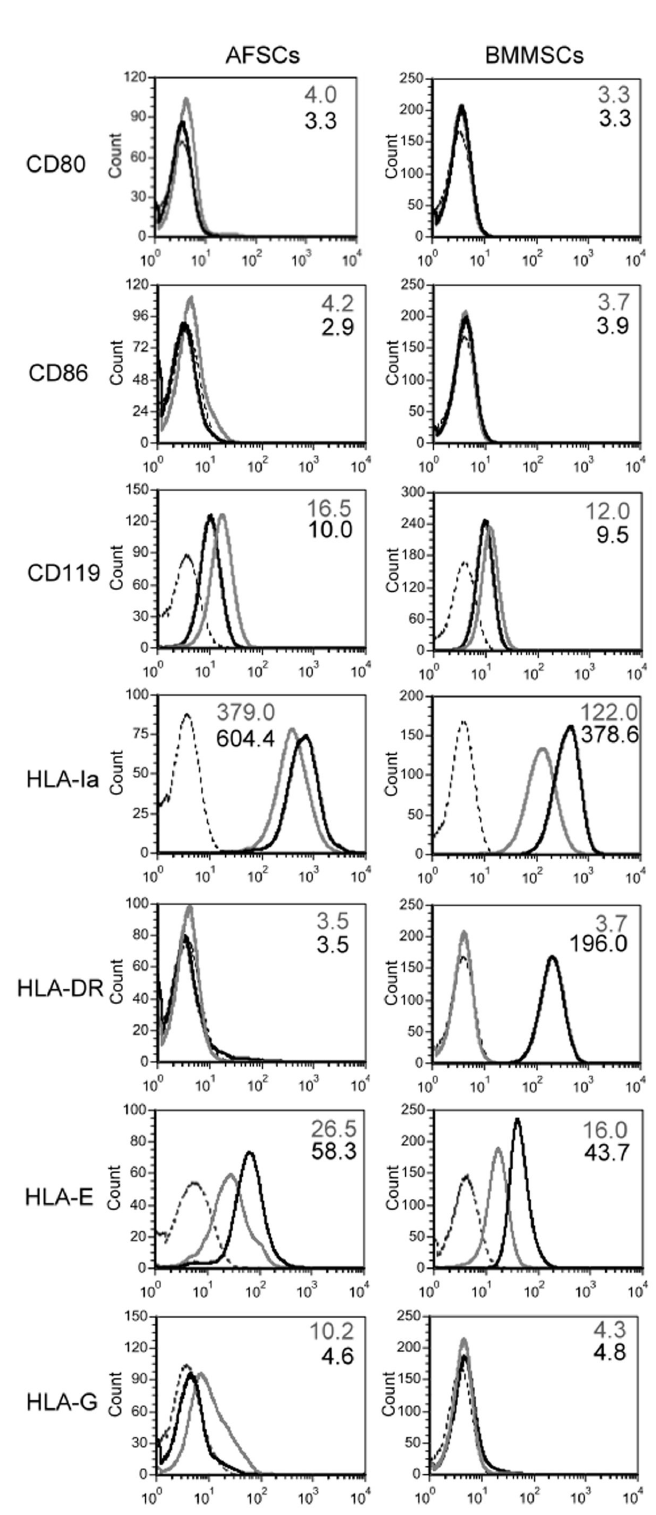
Figure 2. AFSCs surface marker expression after γ-IFN treatment. Surface marker expression was analyzed by flow- cytometry. Dotted lines represent the isotype control. Gray lines and black lines represent the expression of specific antigens without or with 200 U/mL γ-IFN treatment for 48 hr, respectively. Geometric means of fluorescence intensity are indicated in the top of each box (gray: no γ-IFN treatments; black: γ-IFN treatments). doi: 10.1371/journal.pone.0076118.g002 PLOS ONE |